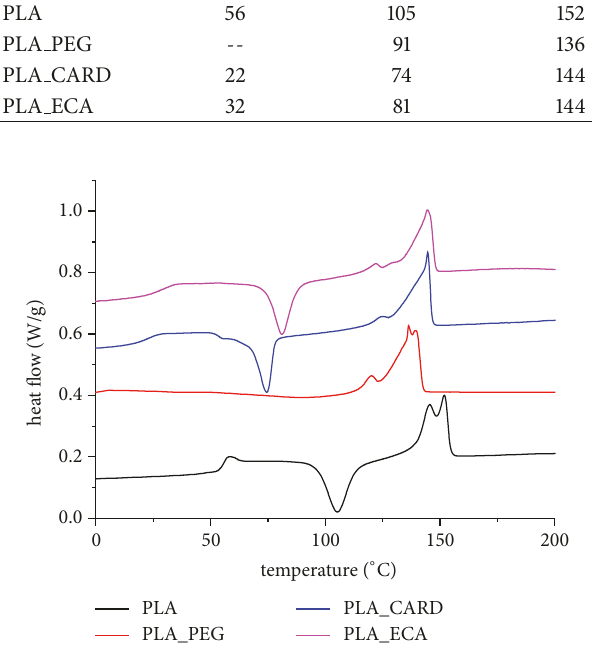
Figure 1: DSC on rotational molded